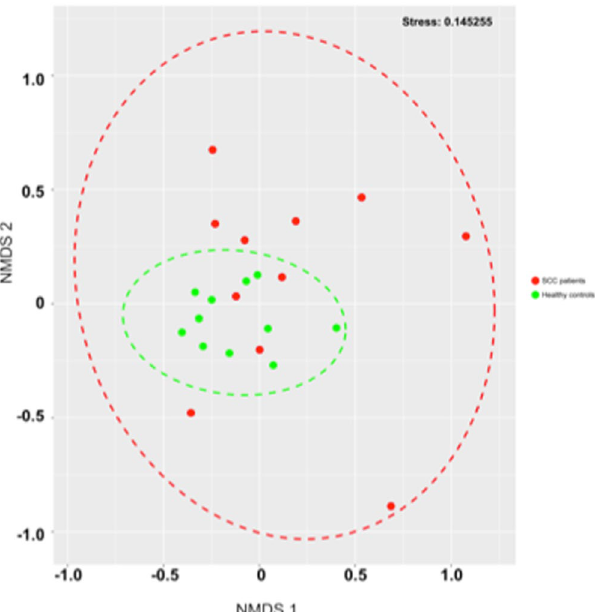
Figure 2. Non-metric multidimensional scaling (NMDS) plot of microbial communities, based on OTU level, derived from saliva of healthy controls (green) and SCC patients (red). Red dots within the green circle represent HPV-positive